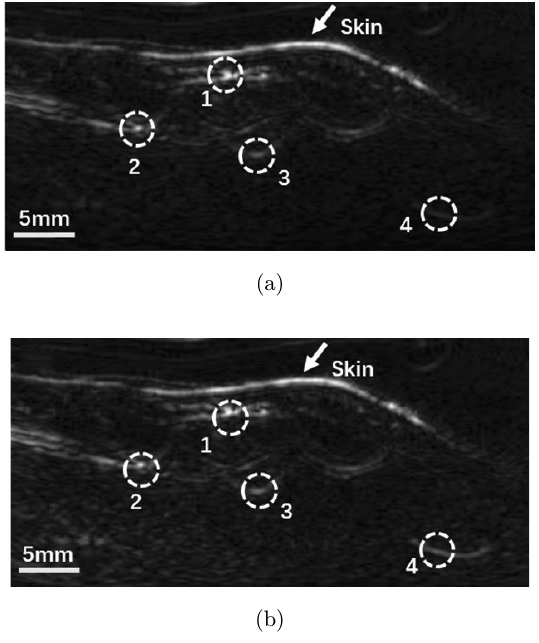
Fig. 7. (a) PA image of breast without optical °uence com- pensation. (b) PA image of breast with optical °uence compensation.